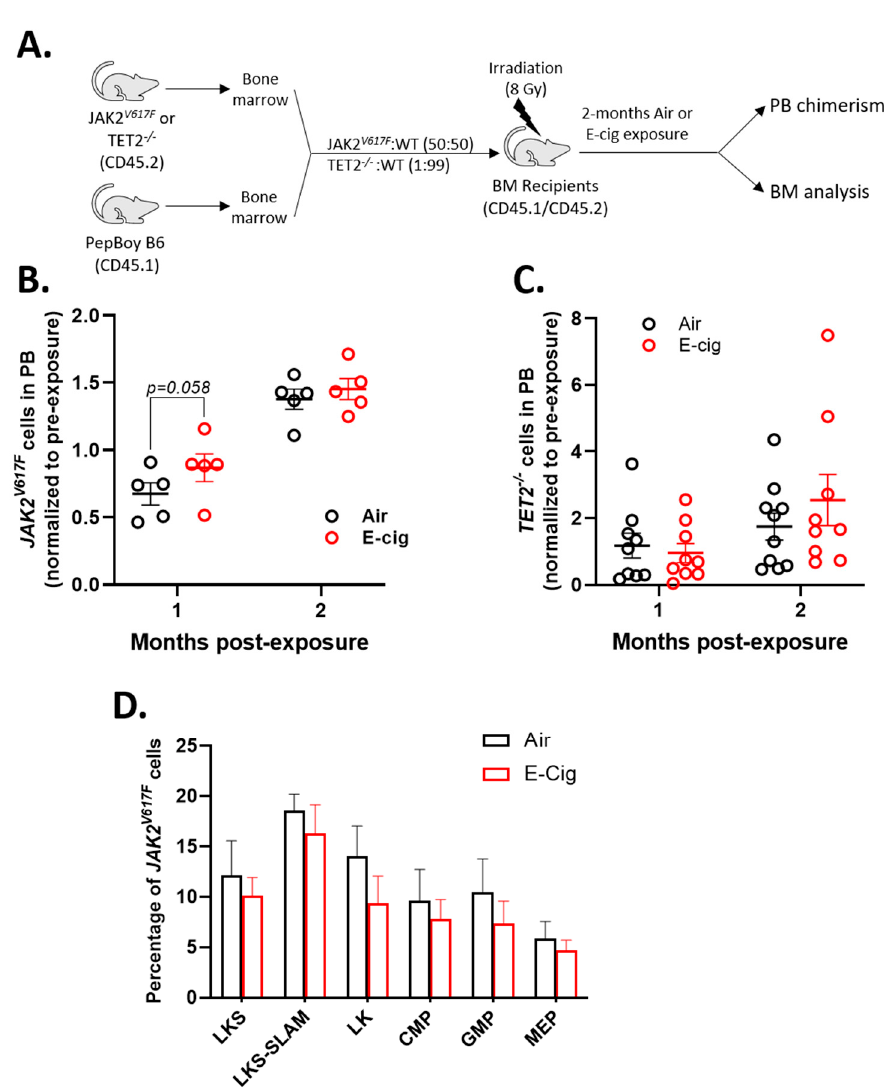
Figure 6. E-cigarette exposure increases peripheral blood chimerism of JAK2 V617F mutant cells. ( A ) Experimental design. Relative change in peripheral blood chimerism of ( B ) JAK2 V617F mutant and ( C ) TET2 − / − cells from pre-exposure. ( D ) Relative contribution of JAK2 V617F to HSPC populations after 2 months of exposure. Data are shown as mean ± SEM. n = 5–10 mice/group.